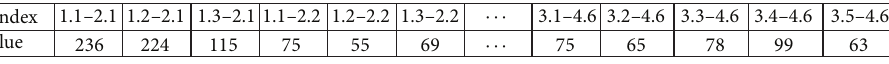
Figure 4: Chromosome structure.